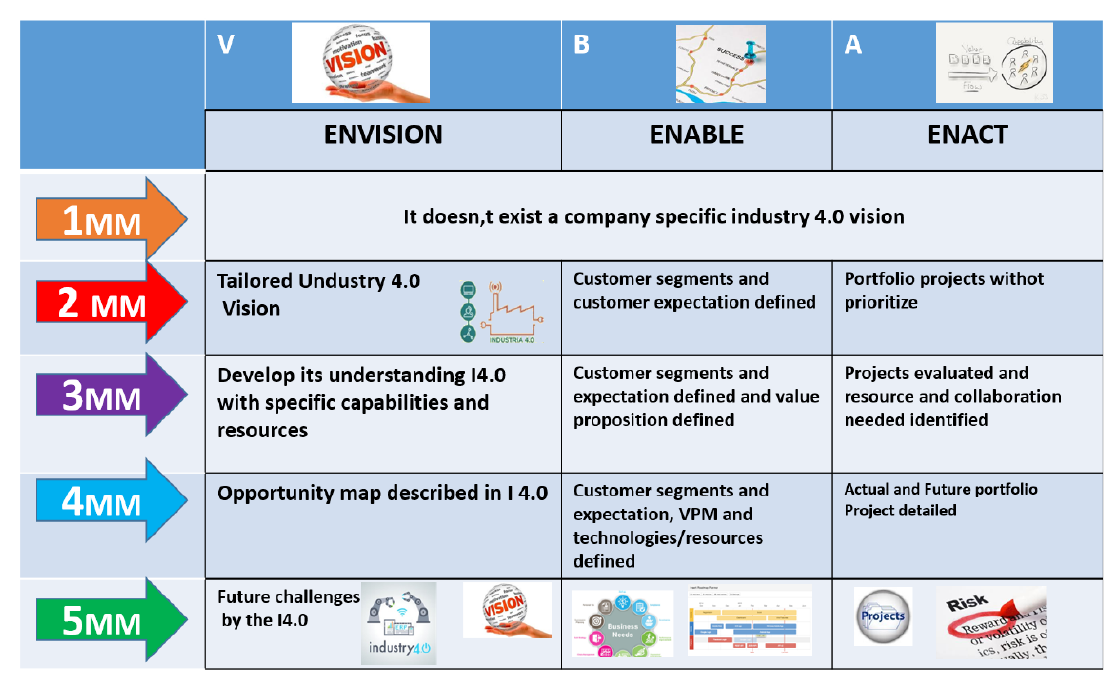
Figure 2. Maturity Model to the Industry 4.0